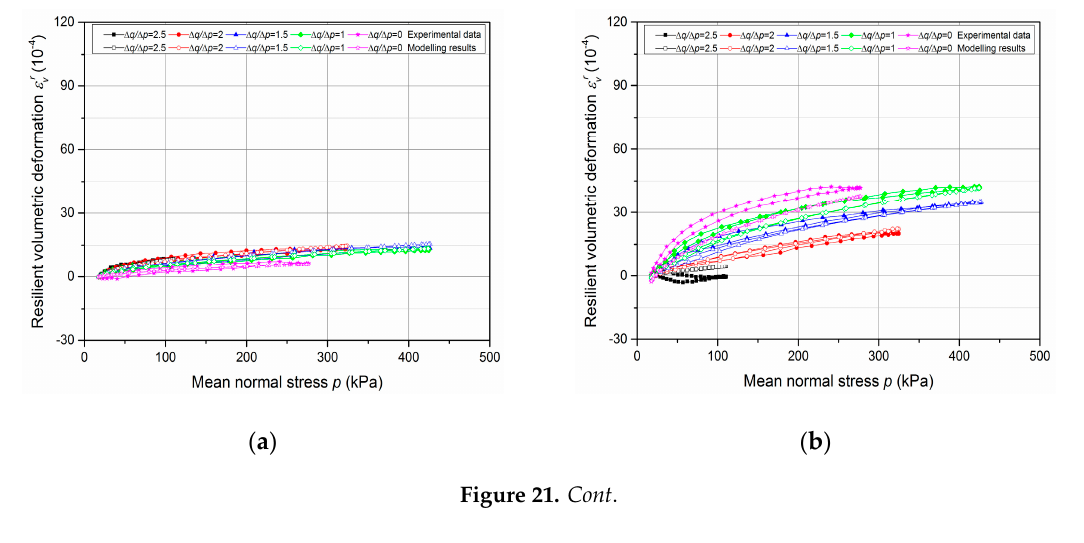
Figure 20. Relationships between γ 1 and 1 / γ 3. Table 5. Parameter optimization of Equations (8)–(11) for UGM Bréfauchet with γ 1 .